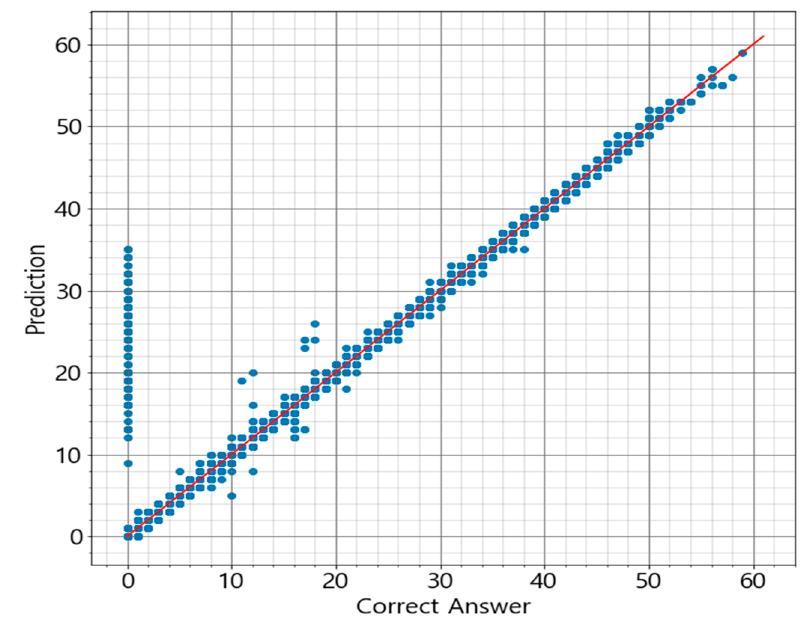
Figure 22. Prediction of sap amount based on Random Forest.